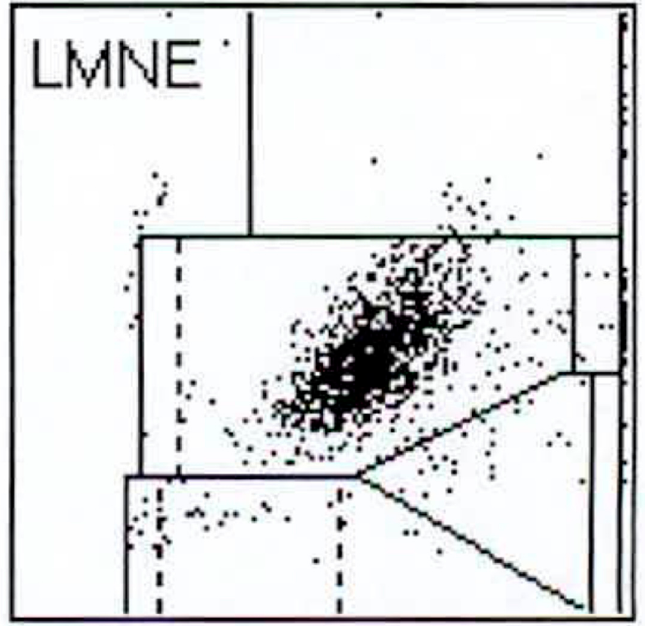
Figure 4. LMNE matrix of a type II (infection type) with a cloud in the area of the neutrophil leukocytes in a 75-year-old patient with a late periprosthetic joint infection of a total knee arthroplasty. The measured cell count was 1840 cells/ μ L.